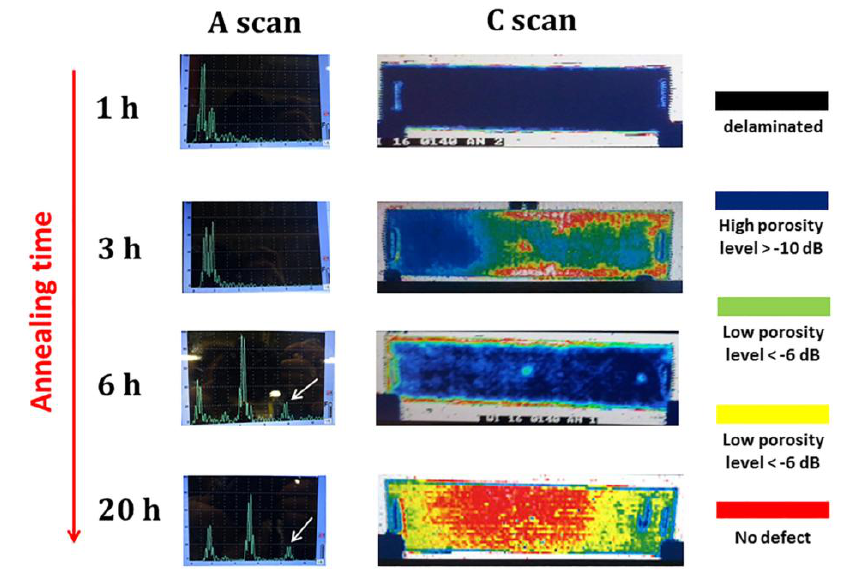
Figure 9. Non-destructive evaluation of blank laminates annealed at different times.